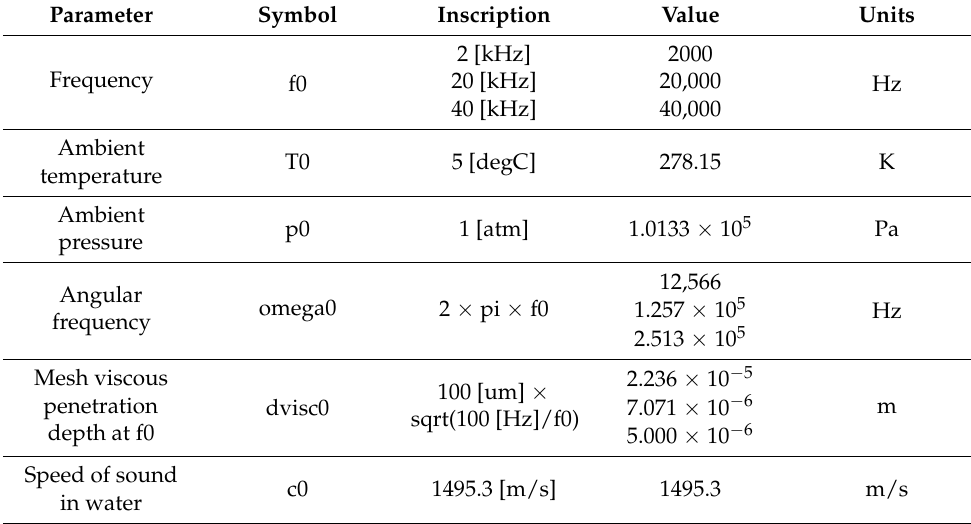
Table 1. Parameters of the model of fluid flow simulation in nanopores.